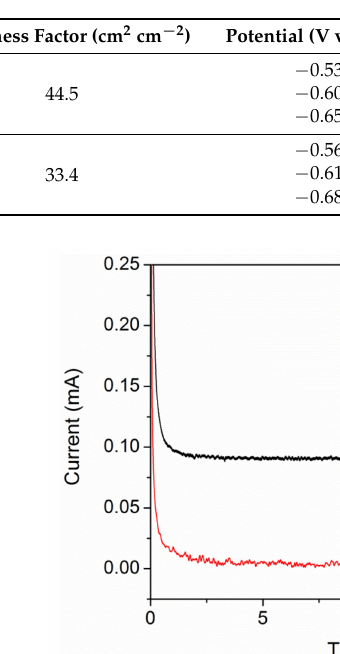
Table 2. The specific activity for the formation of CO on Ag foam and pristine Ag.